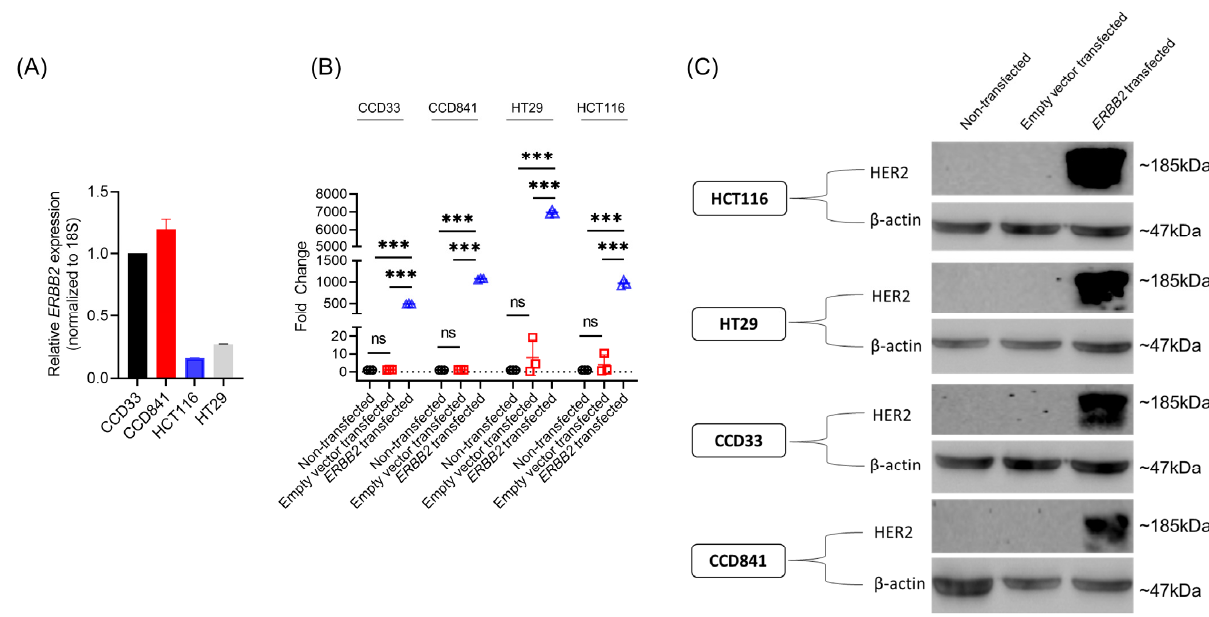
Figure 1. Validation of successful ectopic overexpression of ERBB2 in the CRC (HCT116 and HT29) and normal colon (CCD33 and CCD841) cell lines. ( A ) Relative ERBB2 expression in the normal colon cell lines CCD33 and CCD841 and the CRC cell lines HT29 and HCT116 as determined by qRT-PCR. Data were normalized to the expression of the internal control 18S rRNA gene and fold expressions were plotted relative to expression in the CCD33 cells. Data represent the mean ± SD of three independent experiments. ( B ) Relative ERBB2 expression in non-transfected and either empty pcDNA3 vector or pcDNA3- ERBB2 transfected HCT116, HT29, CCD33, and CCD841 cells as determined by qRT-PCR. Data were normalized to the expression of the internal control 18S rRNA gene and fold expressions were plotted relative to expression in the non-transfected cells. Data represent the mean ± SD of three independent experiments. *** p < 0.001; ns: not significant. ( C ) Same as B, but relative HER2 protein expression was determined in the different experimental conditions. Blots were re-probed with anti- β -Actin antibody to confirm equal loading across the lanes. The representative blots from three independent experiments are shown.